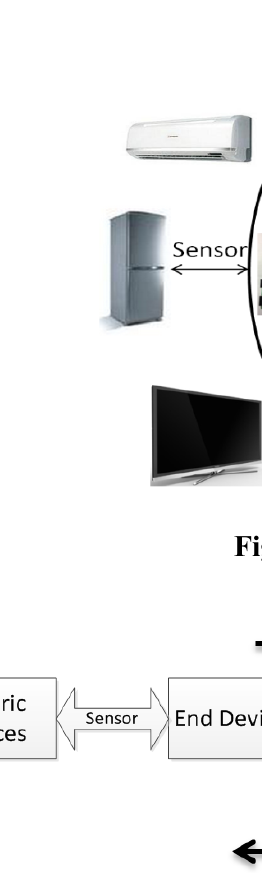
Figure 8. Infrastructure of the ZigBee network.